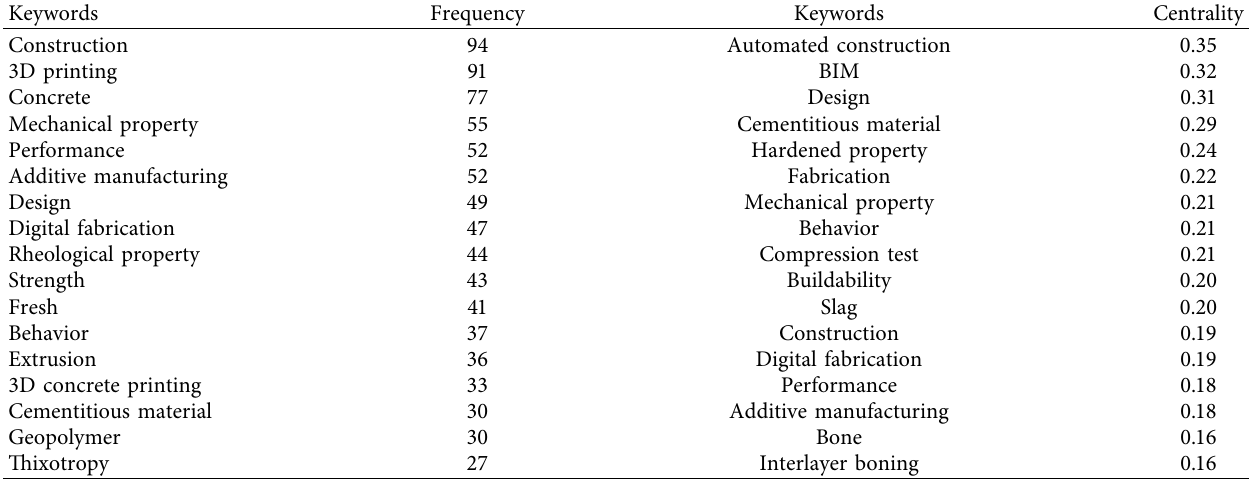
Table 2: Keywords ranked according to frequency and